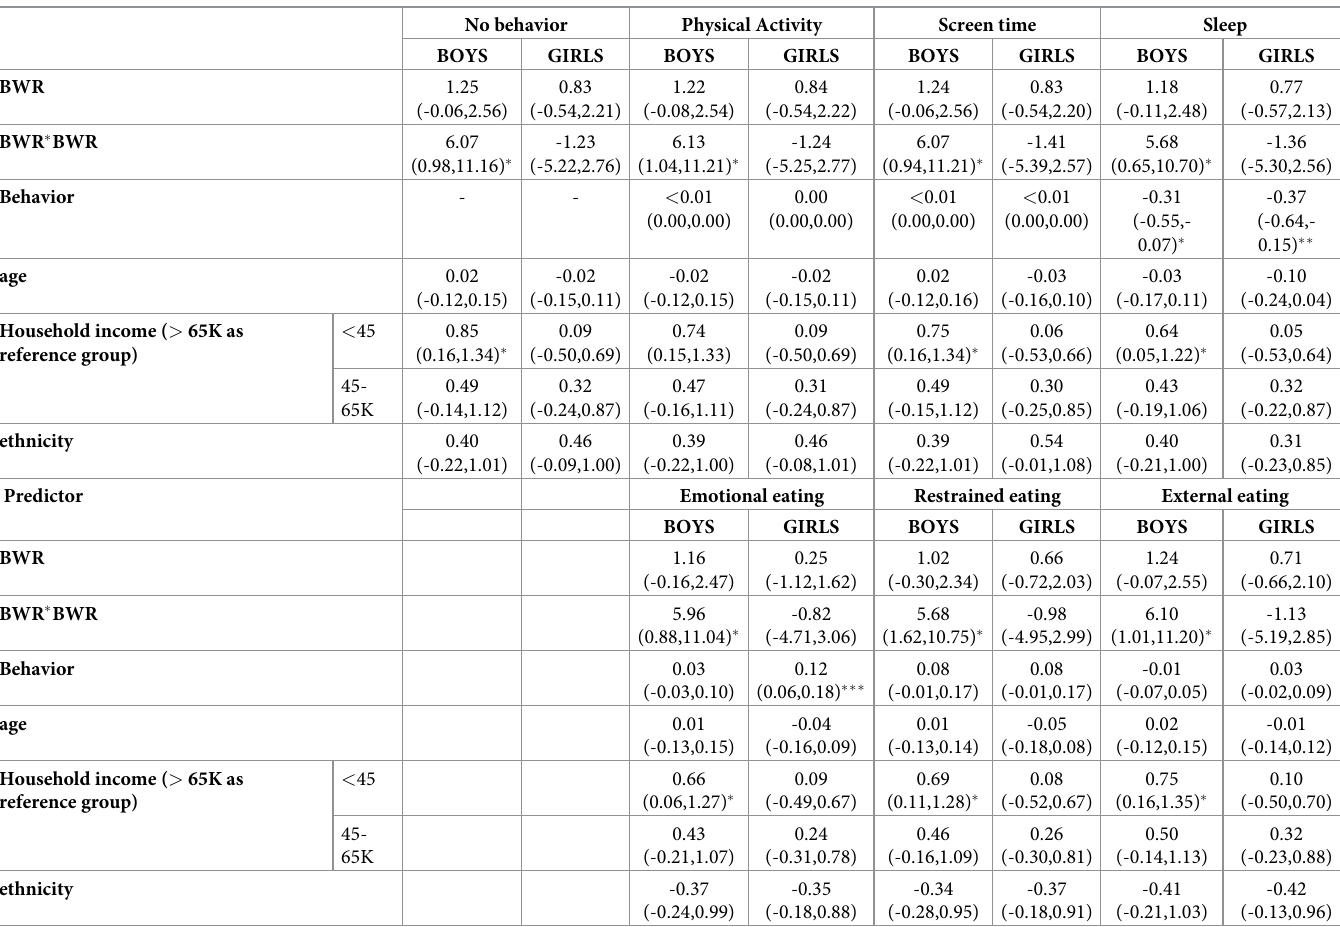
Table 3. Results of models (estimates (95% CI)) testing associations between birth weight ratio and zBMI accounting for individual behaviors, by